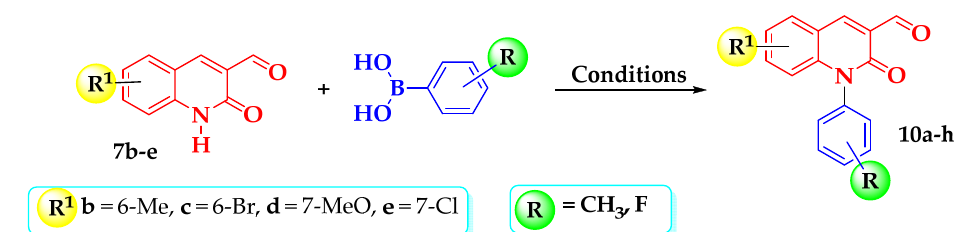
Table 3. N -arylation of different substituted 3-formylquinolones a .